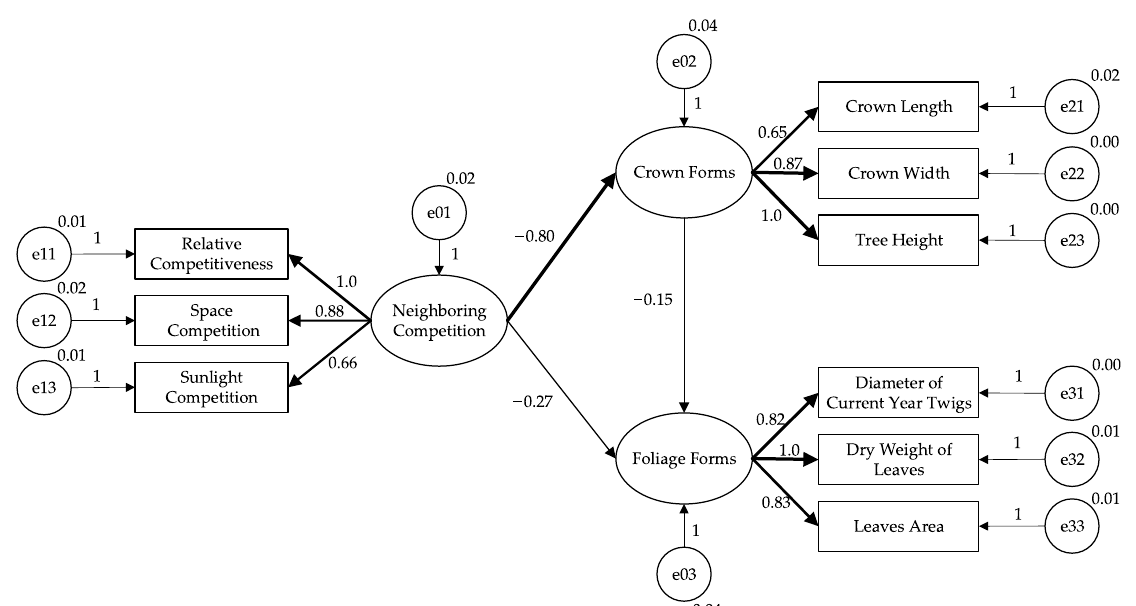
Figure 6. Structural equation model for the response of visual forms to the neighboring competition. Ovals and rectangles represent latent variables and observed variables, respectively. Circles represent the error variables. The numbers by the path are the unstandardized path factor loading. The arrows represent the cause-and-effect paths; the width of each arrow in the diagram corresponds to the value of the respective standardized solution.